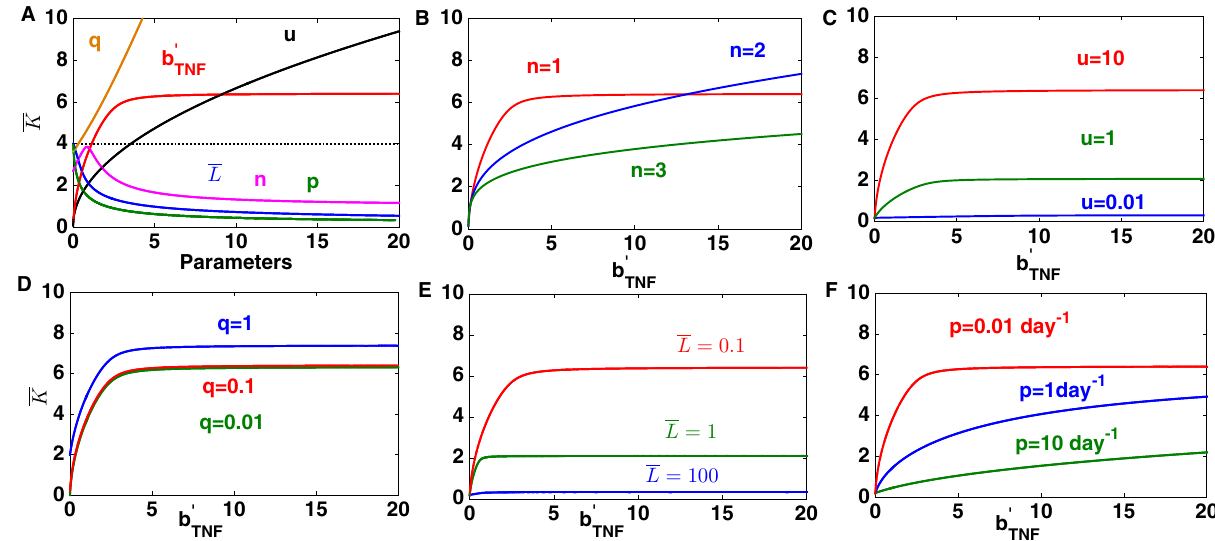
Figure 2. Steady state behavior of the subnetwork mediated by TNF α (Fig.1B). ( A ) Steady state response curve of the keratinocyte population for varying model parameters of the subnetwork. The “parameters” on ′ , p , q , n , ¯ L , and u and the likely variation is shown by different coloured lines. ( B – F ) the abscissa, represent b TNF The response curve of the keratinocytes as a function of the varying level of TNF α can be refined and adjusted by changing other parameters. Effect of changes in parameters: Hill coefficient ( n ), u , q , ¯ L , and p on the steady ′ TNF α ), respectively. The default parameters state response of keratinocyte population to varying b TNF (level of ′ = 1 , p = 0.01 day − 1 , q = 0.1 day − 1 , ¯ L = 0.1 , u = 10 , n = 1 , µ K = 0.5 day − 1 , and µ D = 0.2 day − 1 . are: b TNF